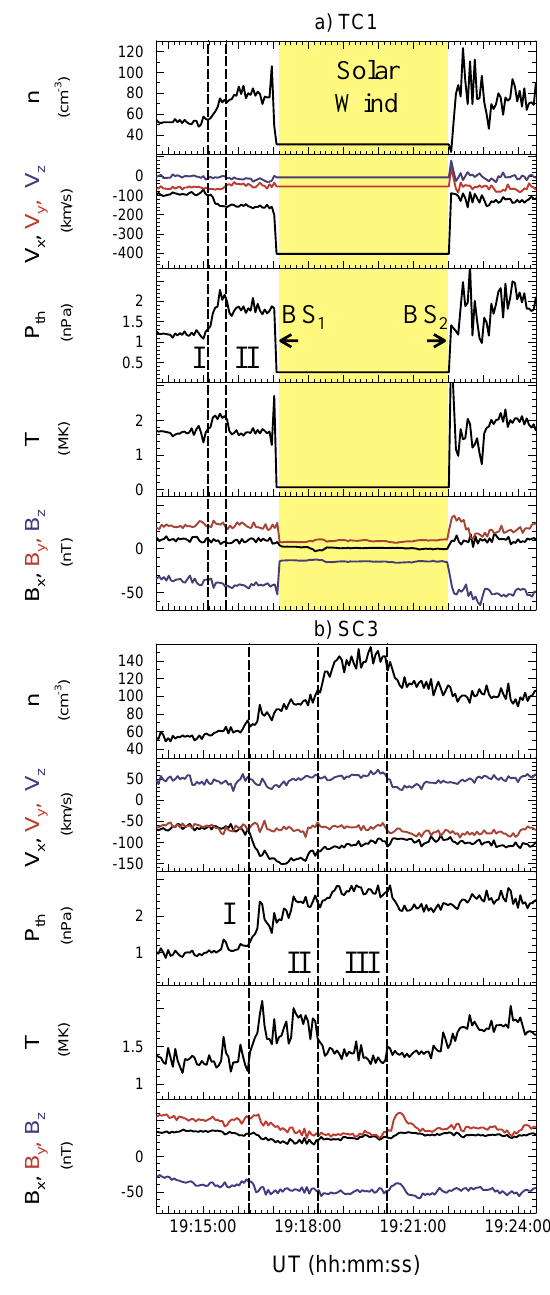
Fig. 1. Ions parameters and magnetic field for the present event as observed by: (a) TC1, (b) SC3. V and B are given in GSE coor- dinates. The vertical lines I, II and III indicate the discontinuities discussed in the text. In-between the outbound BS 1 and the inbound BS 2 bow shock crossings, TC1 is in the solar wind. Due to a satura- tion of the HIA instrument in the solar wind, the plasma parameters plotted in the yellow area in a) are constant values obtained by time averaging ACE/SWEPAM data over a suitable interval in the ACE post-IS